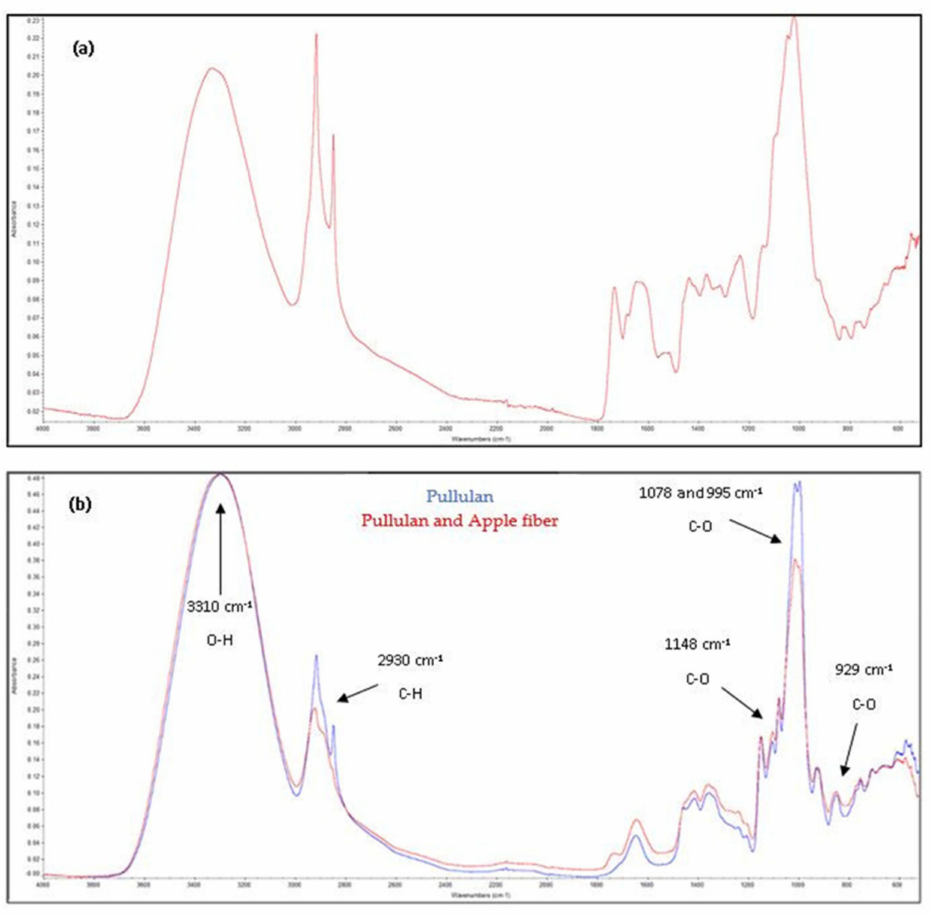
Figure 2. FTIR results of the raw apple fiber ( a ) and the biocomposite films ( b ).